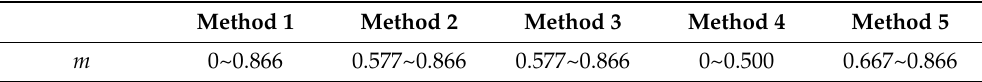
Table 2. Voltage transfer ratio for different modulation methods.